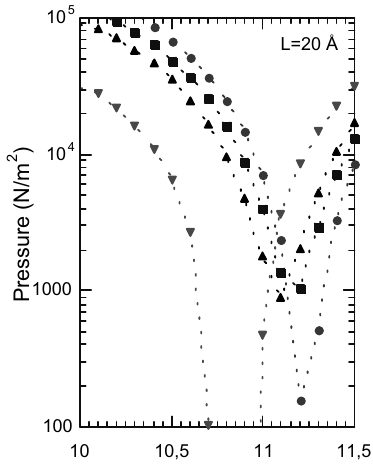
Fig. 6 – The double layer pressure in 0.15 M salt solutions between two plates carrying the same charge density and charge groups as lysozyme proteins 20Å apart. We are in all examples excluding the direct van der Waals pressure between the two plates across a water solution. The different curves correspond to: electrostatics (circles); NaCl (squares); NaI (triangles pointing up); and NaSCN (triangles pointing down). (The lines are only there to aid the eye) (Boström et al.